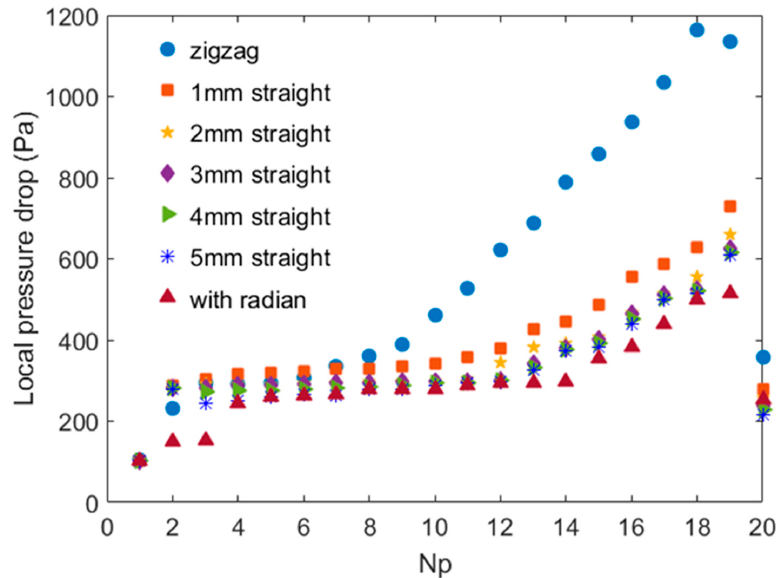
Figure 5. Local pressure drop along the flow direction for different channel shapes.